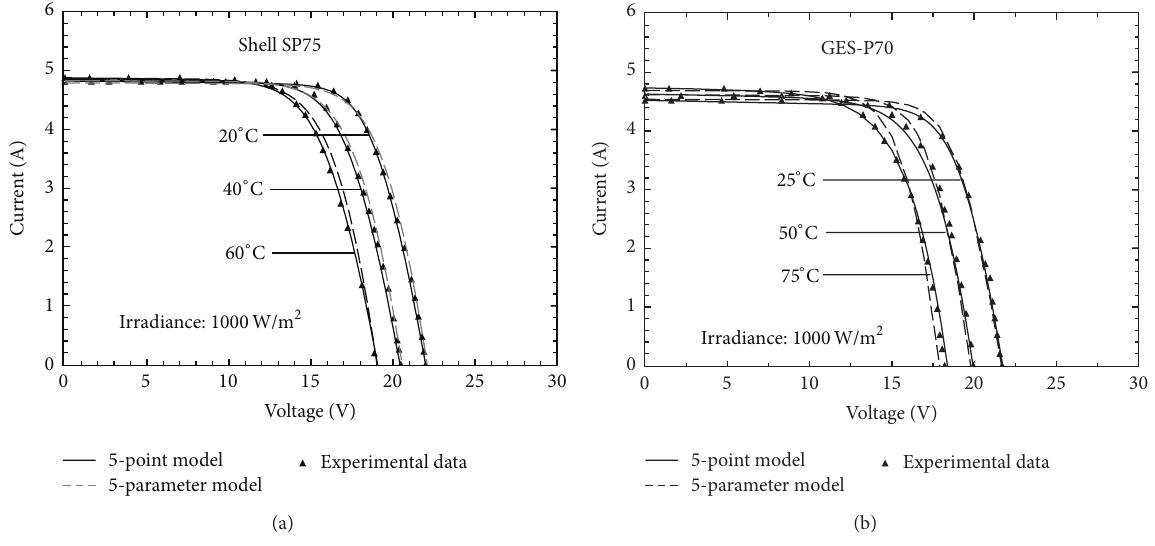
Figure 3: Calculated I-V curves and experimental data of Shell SP75 (a) and GES-P70 (b) at different temperatures, 1000W/m 2 .